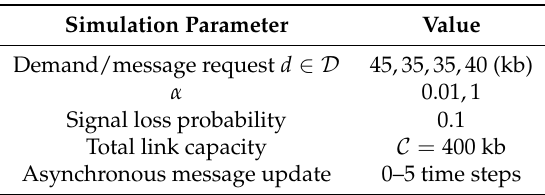
Figure 2. Bidirectional communication network used for the test cases of the proposed DAP routing algorithm: ( A ) Full mesh. ( B ) Partial mesh. ( C ) Bus topology. Table 2. Simulation parameters.